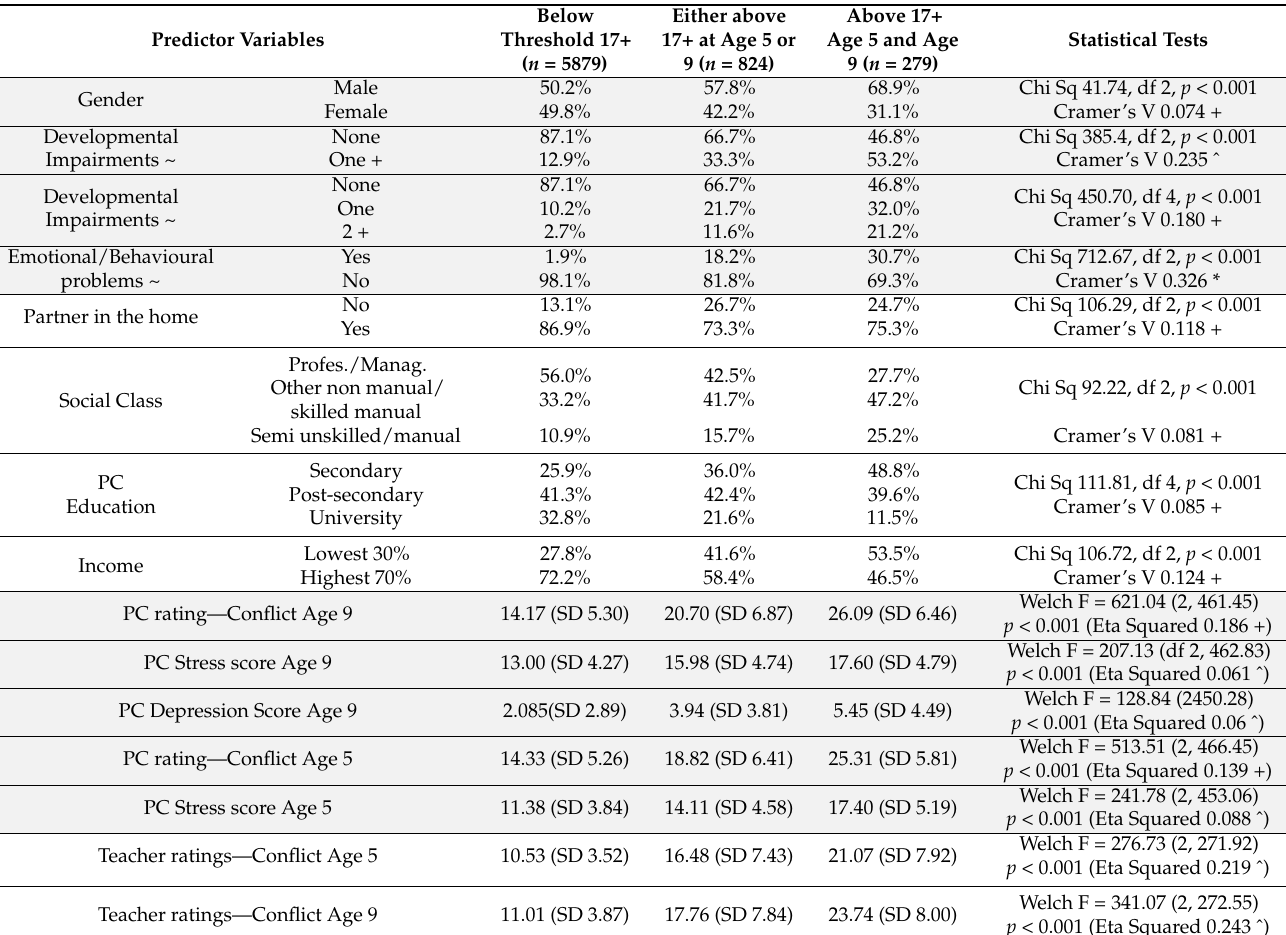
Table 2. The percentage of children or mean scores in each of the three subgroups for the predictor variables listed. Predictor